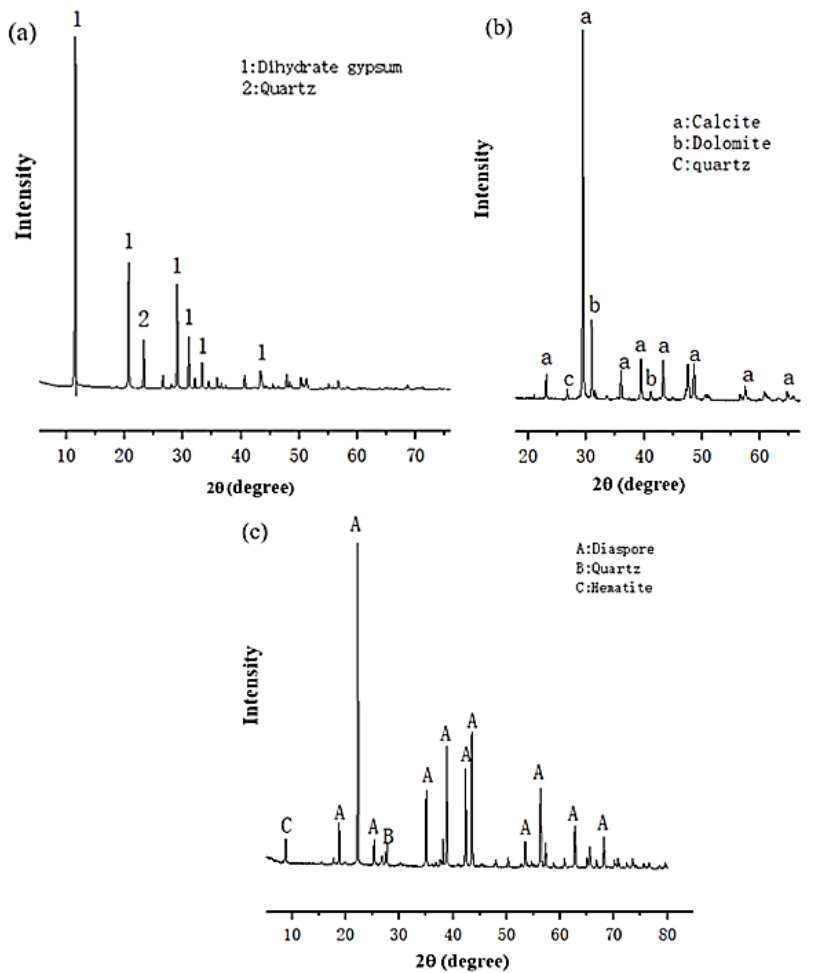
Figure 1. XRD patterns of materials: ( a ) PG, ( b ) limestone, ( c ) bauxite. Figure 2 shows the particle size distribution profile of the three raw materials after grinding. The finer the raw material, the larger the specific surface area, and the faster the raw material reacts to produce clinker minerals during calcination. Therefore, the particle size of the three raw materials was measured using a laser diffraction particle size analyzer (NKT6200, Jinan, China). As shown in Figure 2, the particle size distribution of PG is more concentrated, mainly around 70 µ m. In contrast, the particle size distribution of bauxite and limestone is broader, but the fineness of all three raw materials is controlled to pass through an 80 µ m square hole sieve with a sieve margin of less than 5%. The target phase combinations for CAS clinker are shown in Table 2. Based on the target phase combinations and the chemical composition in Table 1, the ratios for CSA cement raw materials were determined, as shown in Table 3. The ground raw materials were accurately weighed and homogenized according to the ratios in Table 3. The raw material mixture was mixed with 10 wt.% water and pressure molded. After drying in a 40 ◦ C oven, it was placed in a high-temperature furnace for firing. The firing process is shown in Figure 3. After calcination, the clinker was removed for rapid cooling. The samples were cooled and placed in a planetary ball mill for 5 min, and then ground finely in an agate mortar to pass through an 80 µ m sieve. Analytical tests were carried out to determine the optimum raw material ratio, different calcination processes were used to prepare the cement clinker, and the effect of calcination temperature and time on the minerals and compressive strength of the cement clinker was investigated. The calcination conditions for different samples are shown in Table